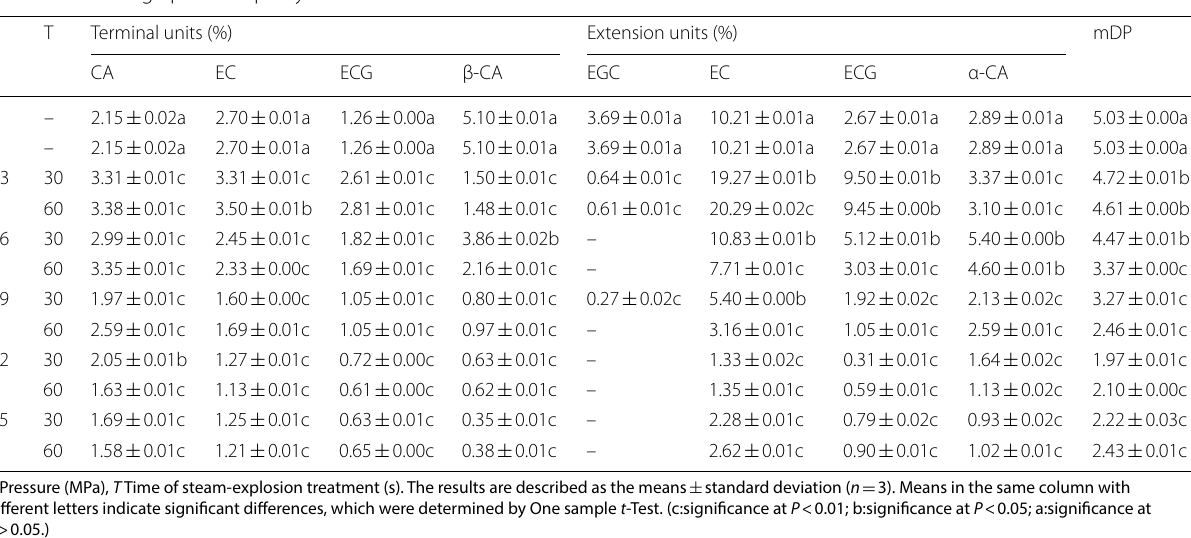
Table 1 mDP of grape seeds procyanidins after SE treatments